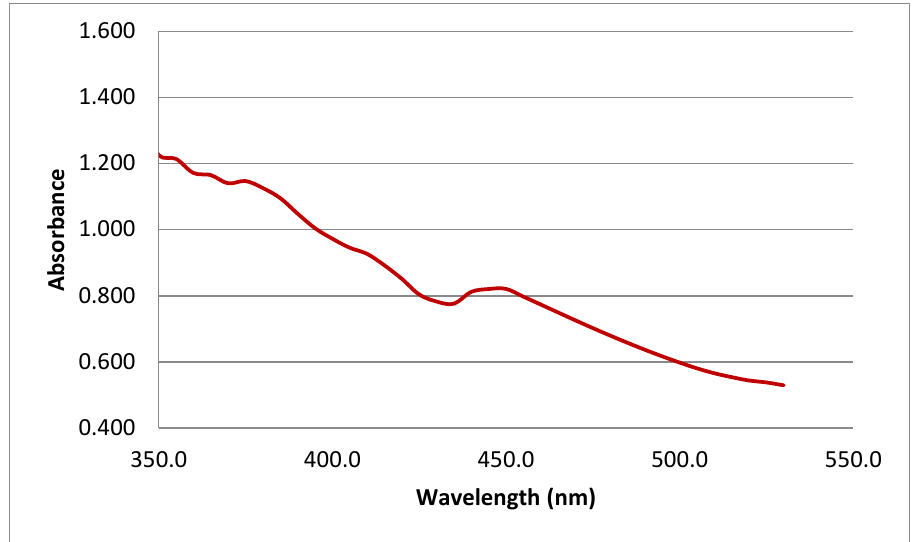
Figure 1. UV – vis absorption spectrum of AgNPs produced by the Ulvan from Ulva lactuca . Figure 1. UV–vis absorption spectrum of AgNPs produced by the Ulvan from Ulva lactuca